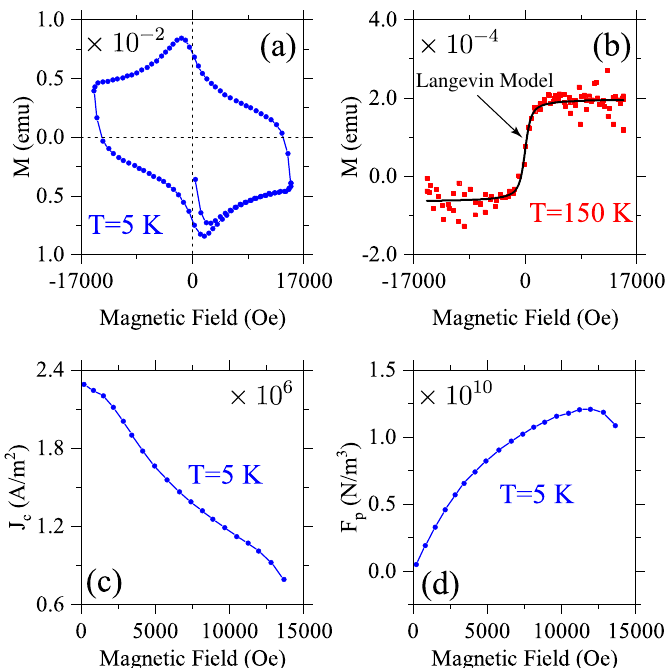
Figure 3. Magnetization versus in-plane magnetic field at ( a ) 5 K and ( b ) 150 K, under zero field cooling regime. Diamagnetic contribution of the MgO substrate was subtracted for results in ( b ). Superconducting current density J c and the macroscopic pinning force density F p are presented in ( c ) and ( d ),